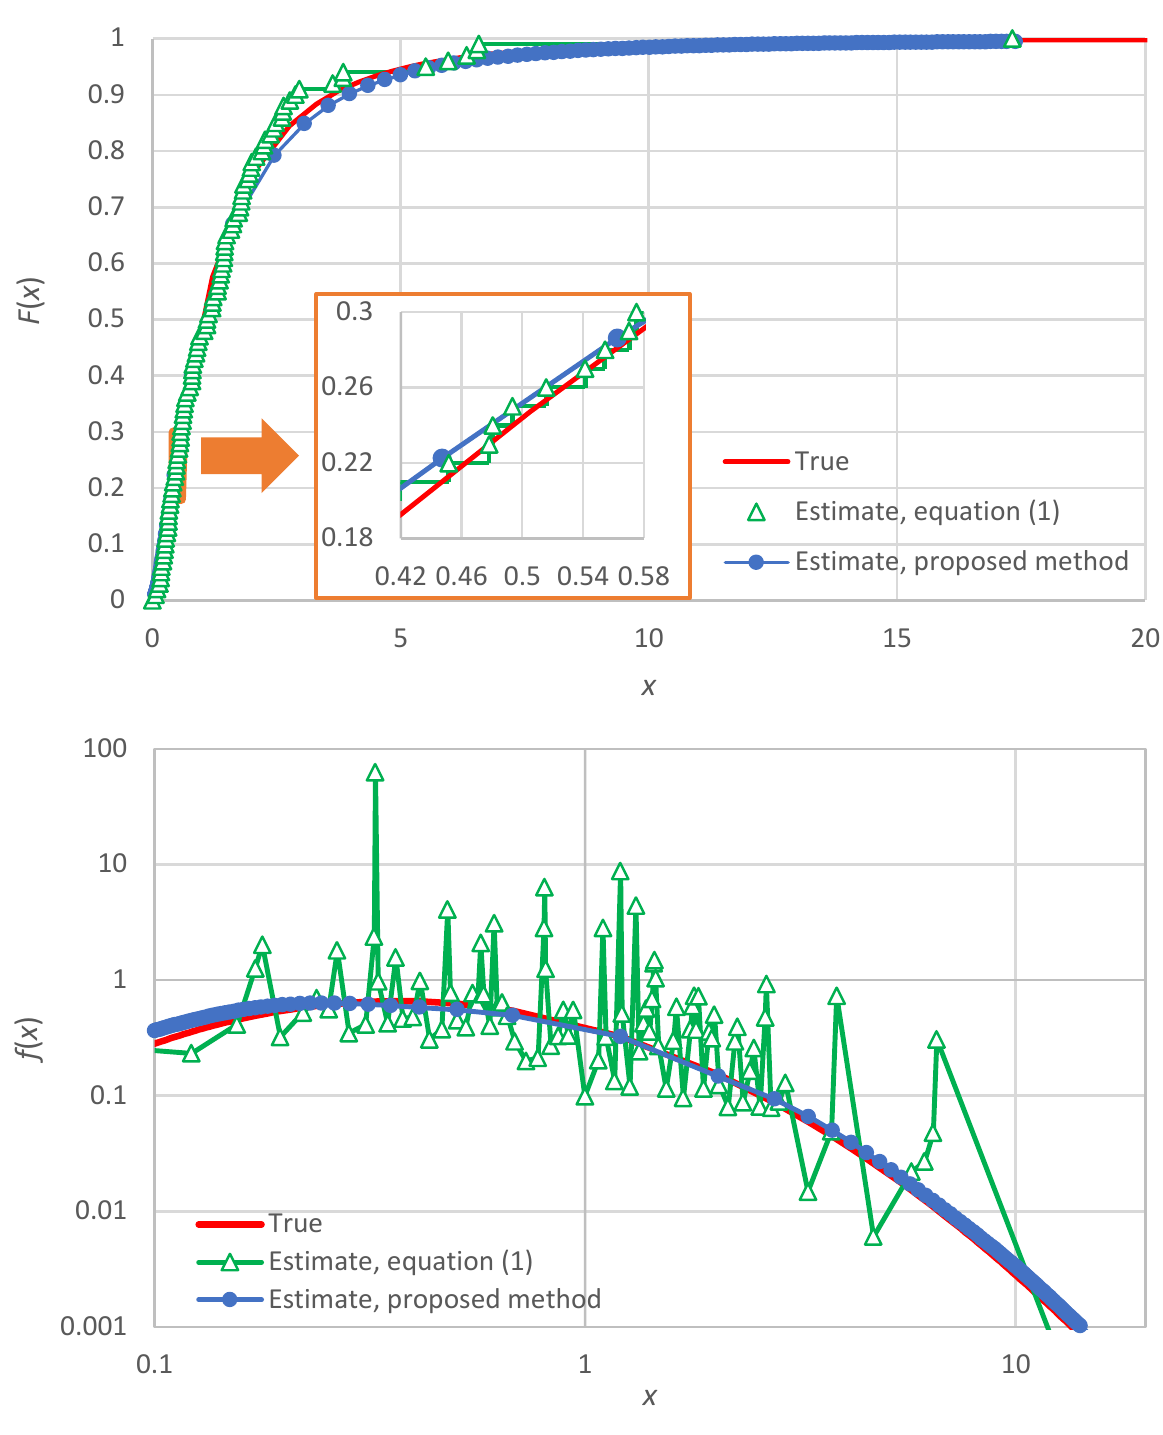
Figure A1. Illustration of the estimate of the distribution function F ( x ) using Equation (1) ( upper , with inset to better depict the staircase form) and that of the probability density f ( x ) ( lower ) as the numerical derivative of F ( x ) with the staircase form replaced by a broken line form. The data series of Figure 1 was used ( n = 100 values, generated from a lognormal distribution with parameters ς = λ = 1; see Table 2). The abscissae of the points of estimates are the midpoints of the intervals (cid:16) (cid:17) x ( i : n ) , x ( i + 1: n ) . As the estimates of f ( x ) vary by orders of magnitude, logarithmic axes are used. In both panels the estimates by the proposed method (from Figure 1) are also shown for comparison.